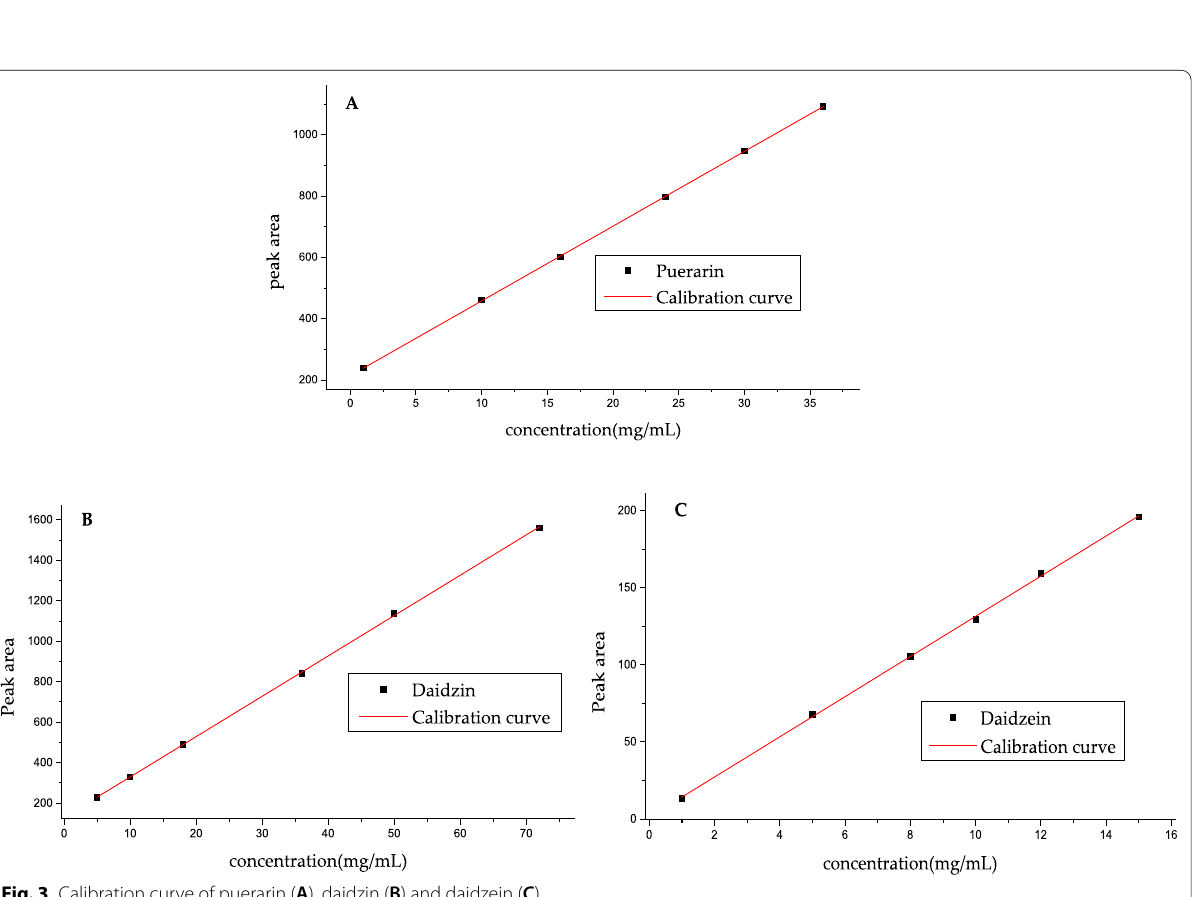
Fig. 3 Calibration curve of puerarin ( A ), daidzin ( B ) and daidzein ( C